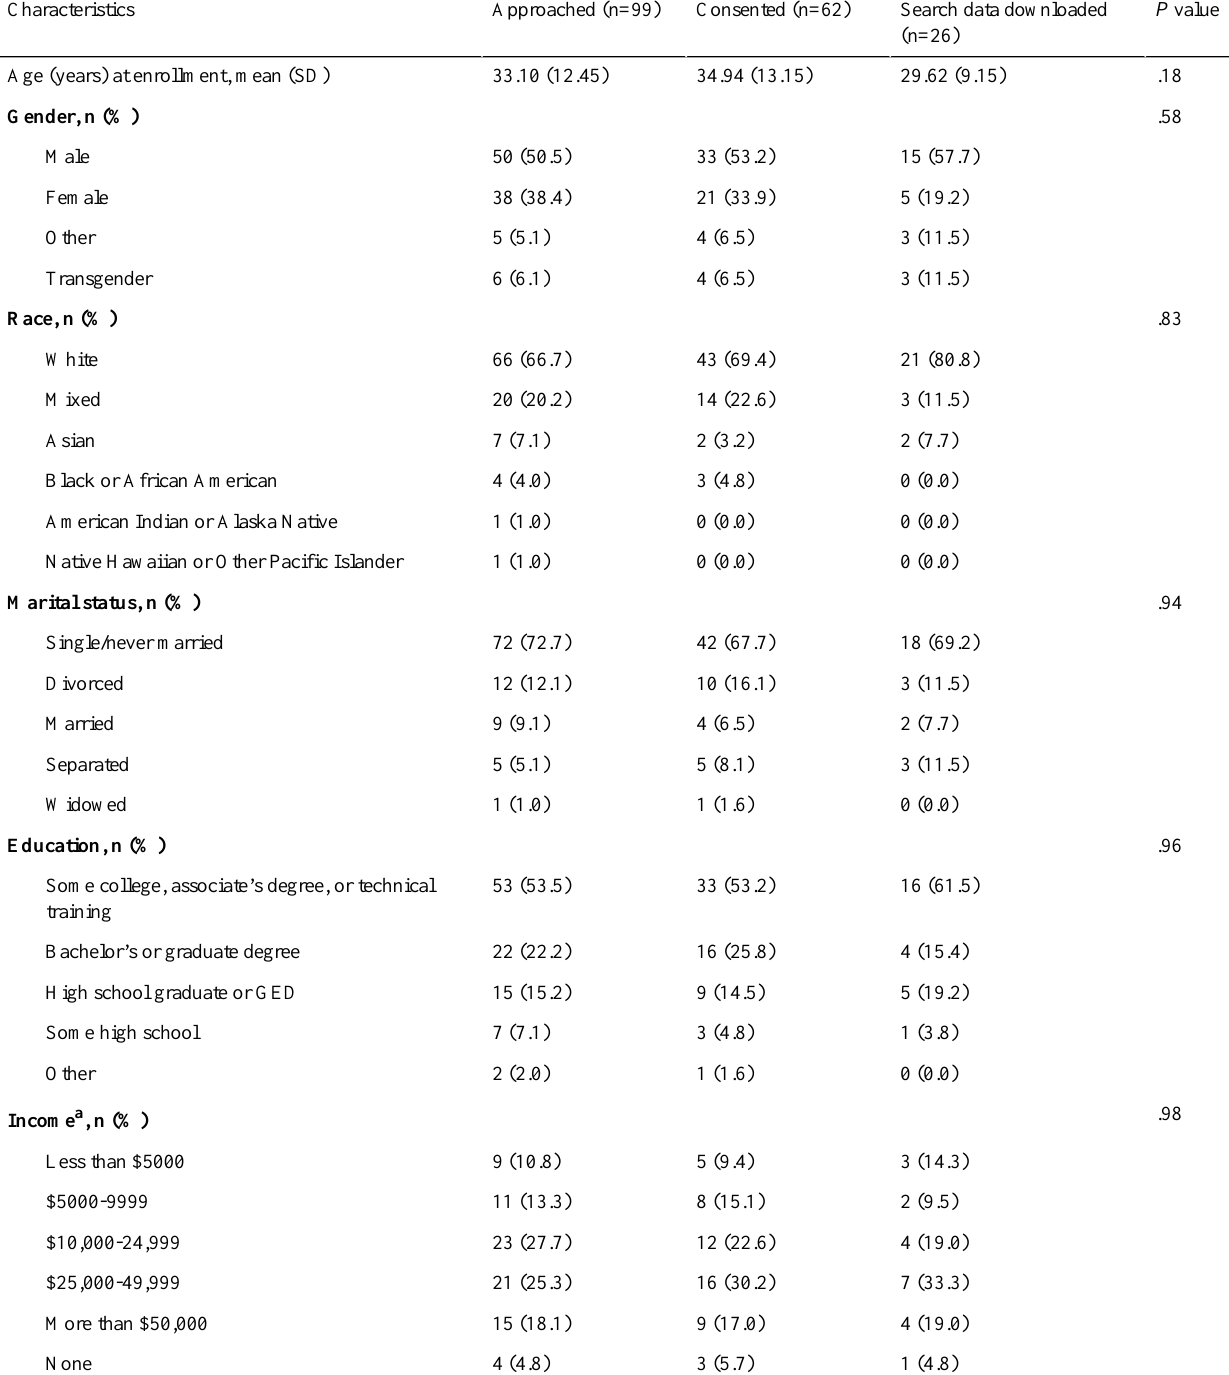
Table 1. Demographic